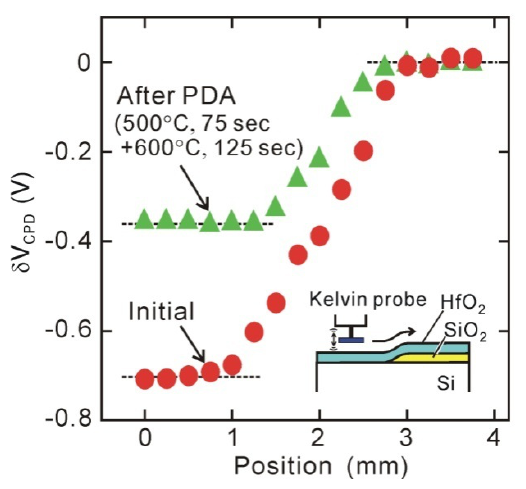
Figure 5. In-situ Kelvin probe measurements for normalized contact potential difference ( δ V ). Large δ V difference between direct-contact HfO CPD CPD structures indicates existence of interface dipole.